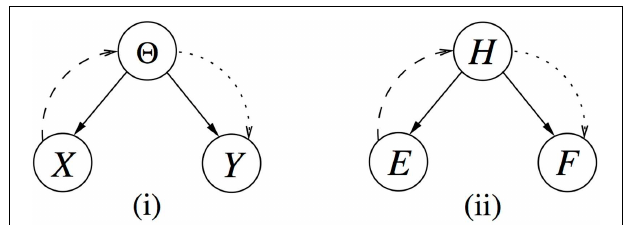
FIGURE 1 | Bayesian networks with variables X and E denoting past data, and Y and F denoting future data. Both past and future data depend on and are related through, in (i) , parameter θ , belonging to the parameter space 2 , and in (ii) , a variable H denoting discrete hypotheses. The dashed edges denote the process when going from past data to the parameter, called inference , whereas the dotted edge illustrates the process of going to future